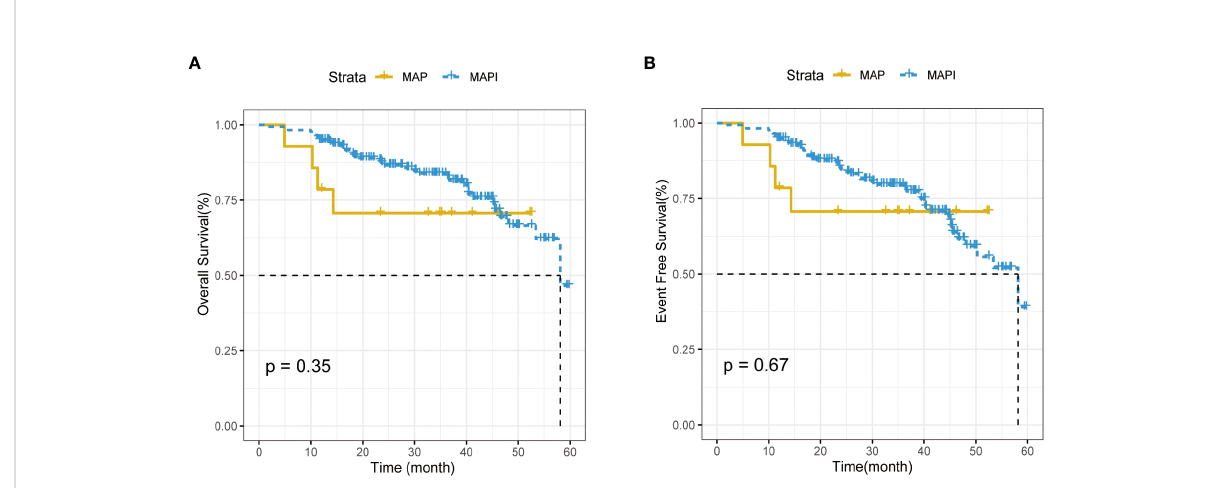
FIGURE 6 (A) . The impact of IFO usage times on the overall survival (OS) rate. (B) . The impact of IFO and IFO usage times on event-free survival (EFS) rate.